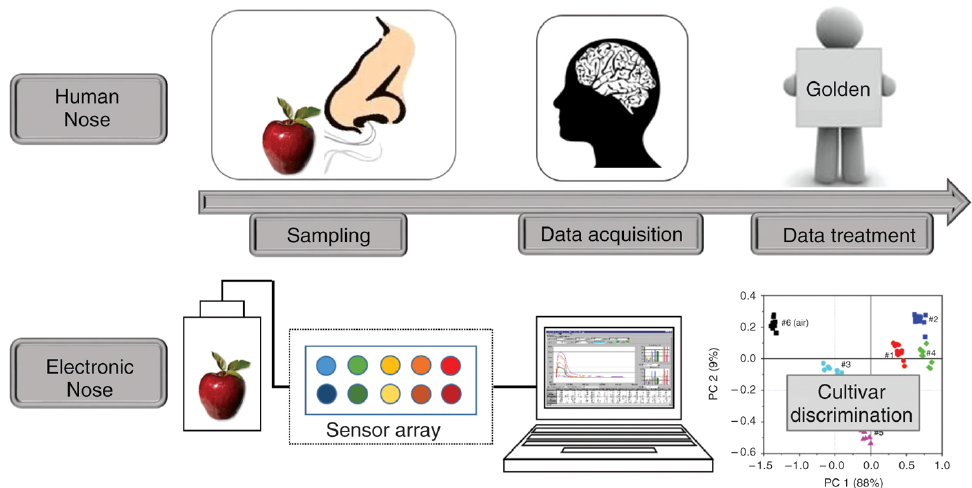
Figure 1: Schematic representation illustrating the principle of human nose and electronic nose. The electronic nose is sensitive to a large number of aromatic compounds by using limited number of non- specific or semi-specific chemical sensors with different and partly overlapping selectivity, able to detect classes of volatile compound in sample